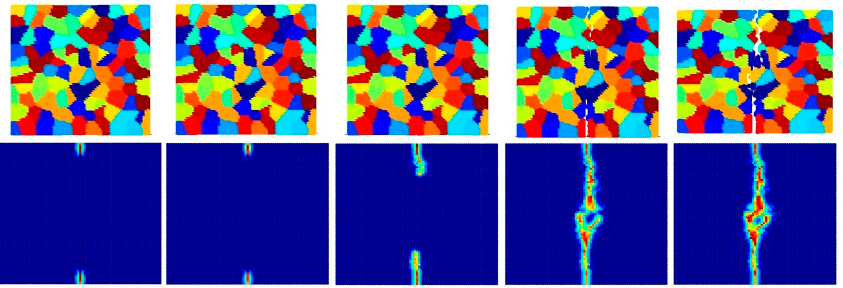
Figure 20. Fracture pattern of polycrystal when β = 2.0 with 74 × 74 particles. From left to right: time = 1.5 µ s, 2.0 µ s, 2.5 µ s, 3.0 µ s, and 3.5 µ s, respectively.